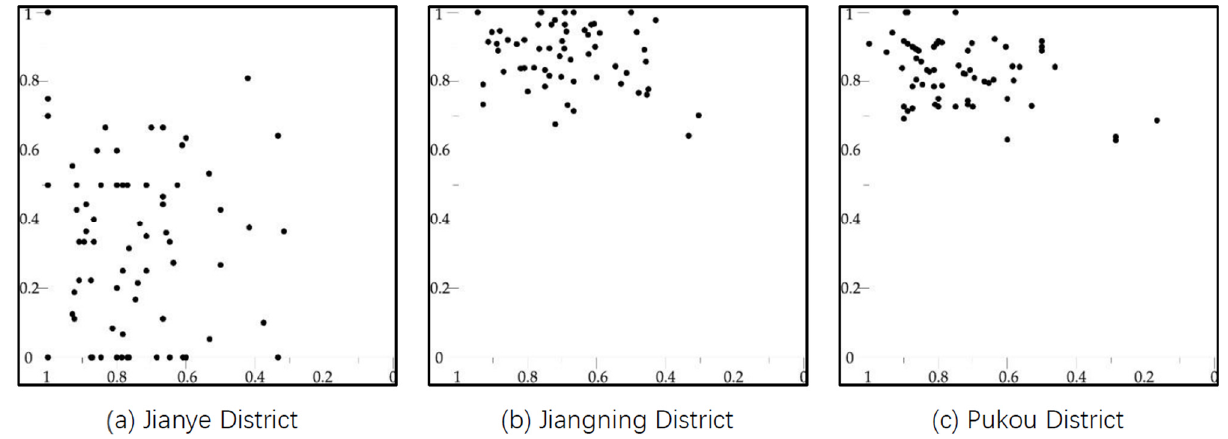
Figure 8. Combined plot of 204 residential areas in Jiangning, Jianye, and Pukou District.